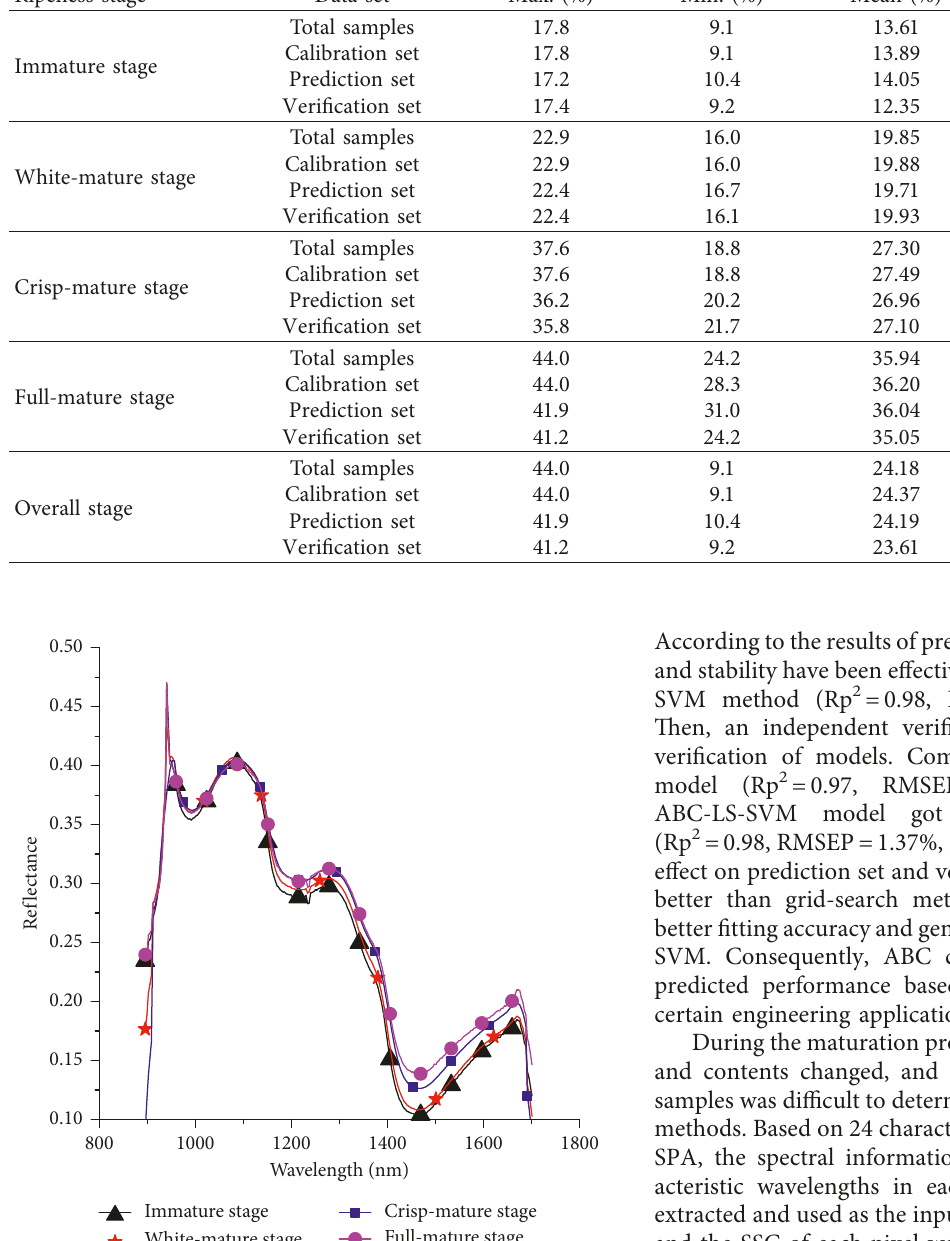
Table 1: Statistics for the SSC (%) at different ripening stages of “Huping” jujubes. Ripeness stage